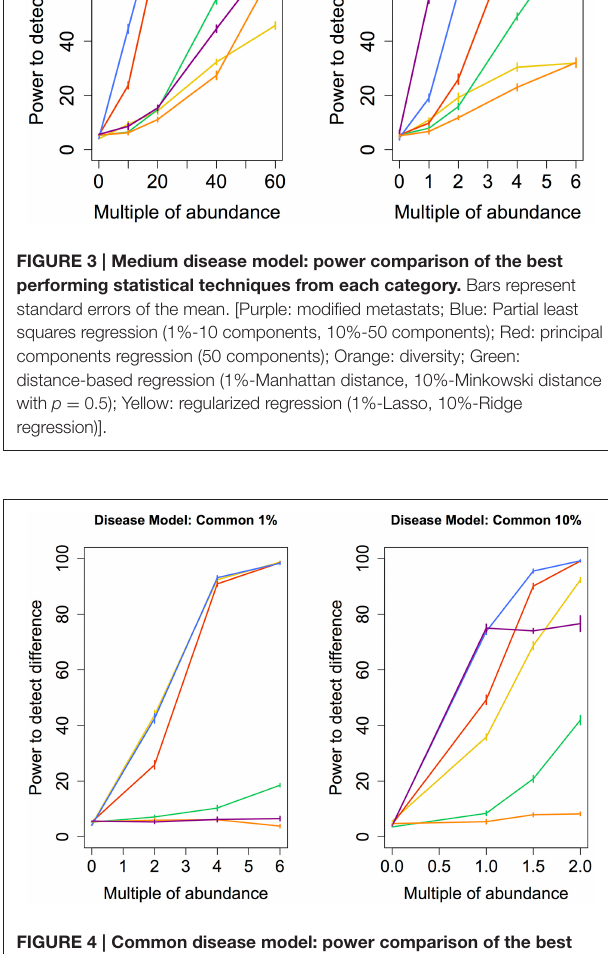
FIGURE 4 | Common disease model: power comparison of the best performing statistical techniques from each category. Bars represent standard errors of the mean. [Purple: modified metastats; Blue: Partial least squares regression (10 components); Red: principal components regression (50 components); Orange: diversity; Green: distance-based regression (Manhattan distance); Yellow: regularized regression (Lasso)].